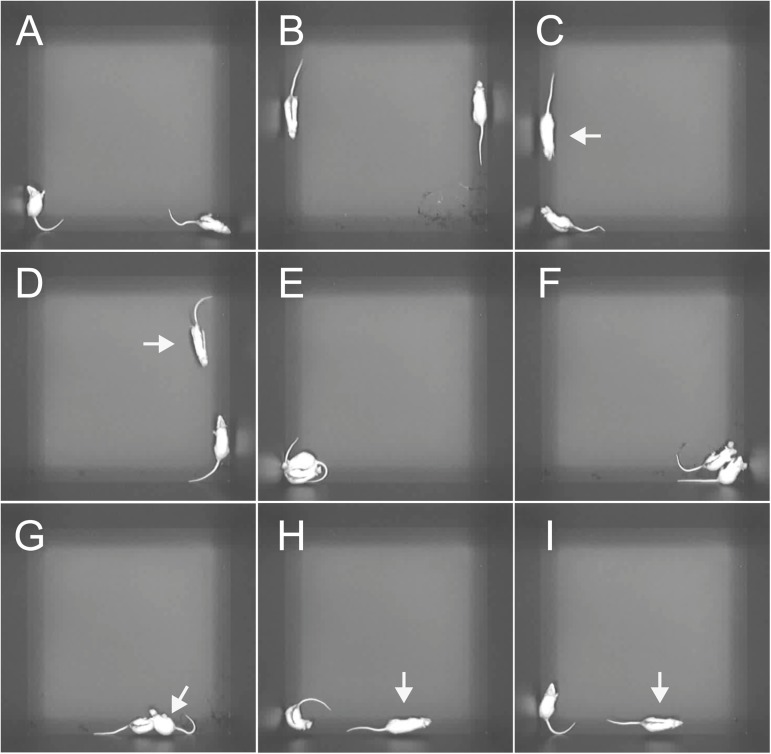
Examples showing the behavior of the rats during the social interaction test.A Tosaka was attached to each animal’s head. The back of one of the pair was marked with black spray. The pair of rats was placed in a test box located in a darkened room. A, B: Sole behavior. Rats are behaving separately. The rat (no mark on its back) is exploring around by itself at the lower left corner of the test box and the partner (a black mark on its back) is resting at the lower right corner (A). Both rats are walking along the wall (B). C, D: Approaching behavior. The rat (arrow) is approaching the partner (C), and the partner (arrow) is approaching the rat (D). E–G: Contact behavior. Rats are sniffing (E) and boxing (F) each other, and the rat (arrow) is pinning and biting the partner (G). H, I: Leaving behavior. The rat (arrow) is leaving the partner (H), and the partner (arrow) is leaving the rat (I).